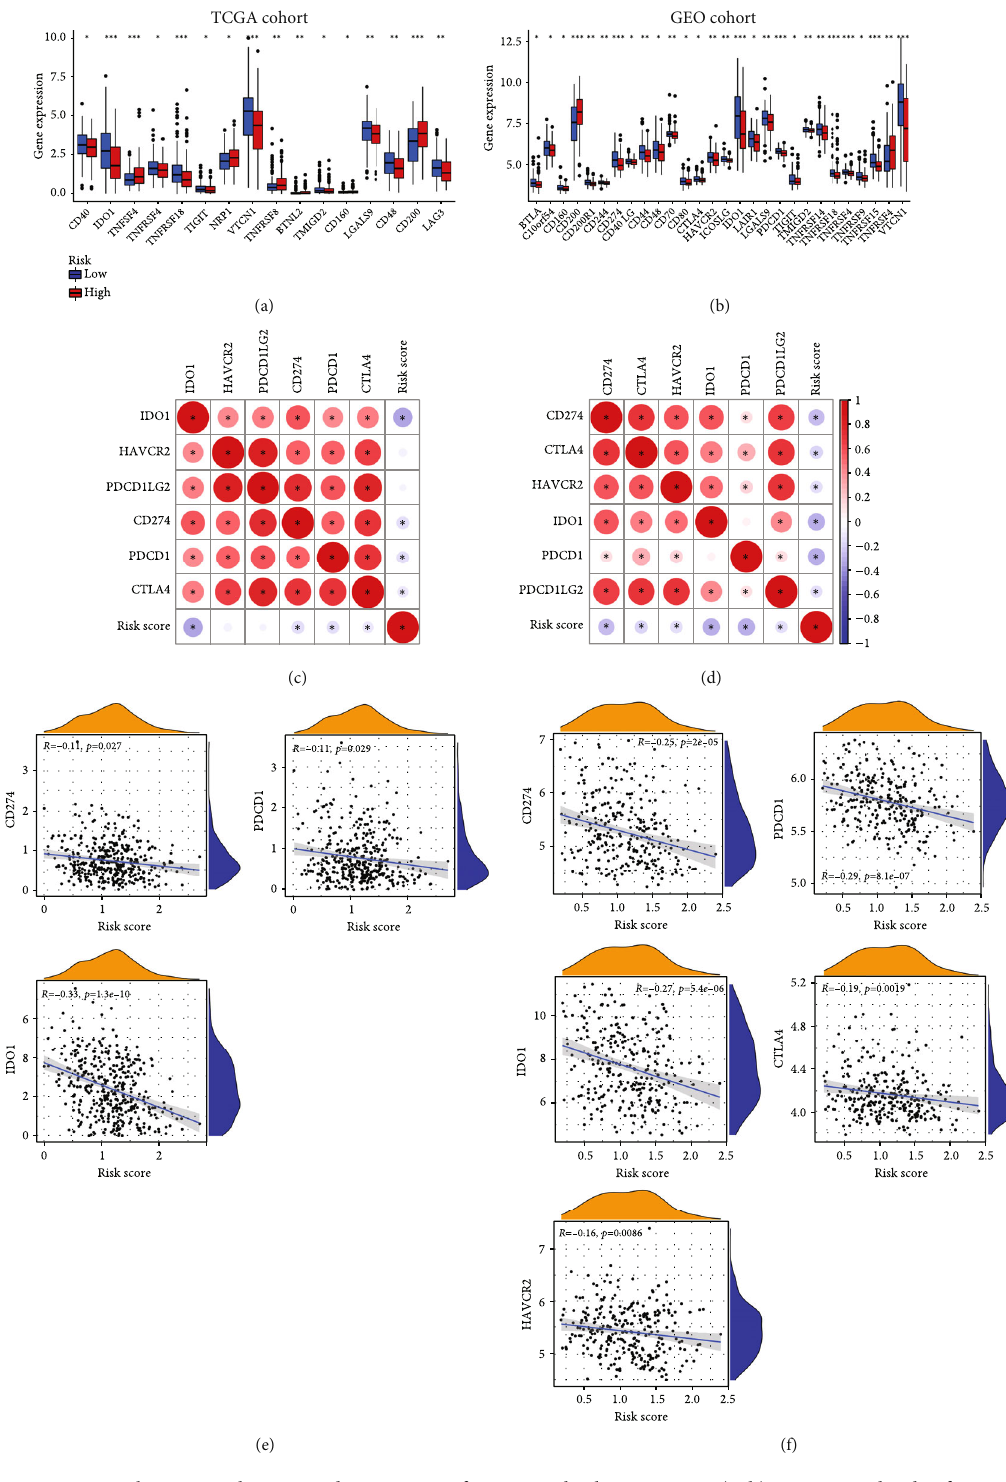
Figure 7: The connections between risk score and expression of immune checkpoint genes. (a, b) Expression levels of immune checkpoint genes in di ff erent risk groups in the TCGA and GEO cohorts. Adjusted p values are shown as ns: not signi fi cant; ∗ p < 0 : 05 ; ∗∗ p < 0 : 01 ; ∗∗∗ p < 0 : 001 . (c, d) Heat maps of the correlations between risk score and expression of six immune checkpoint inhibitor targets in the TCGA and GEO cohorts. The “ ∗ ” represents the statistically signi fi cant p value ( p < 0 : 05 ). (e, f) Correlation analysis between risk score and expression of immune checkpoint inhibitor targets expression in the TCGA and GEO